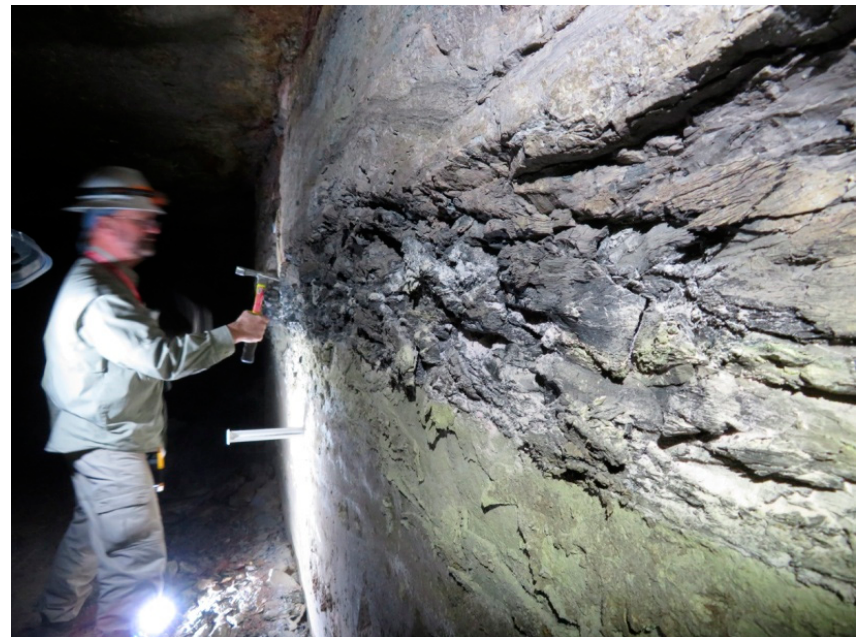
Figure 2. Woody debris layer exposed in the wall of an inactive uranium mine in the White Valley District, San Juan County (UT, USA). 2019 photo, courtesy of Mark Hart.